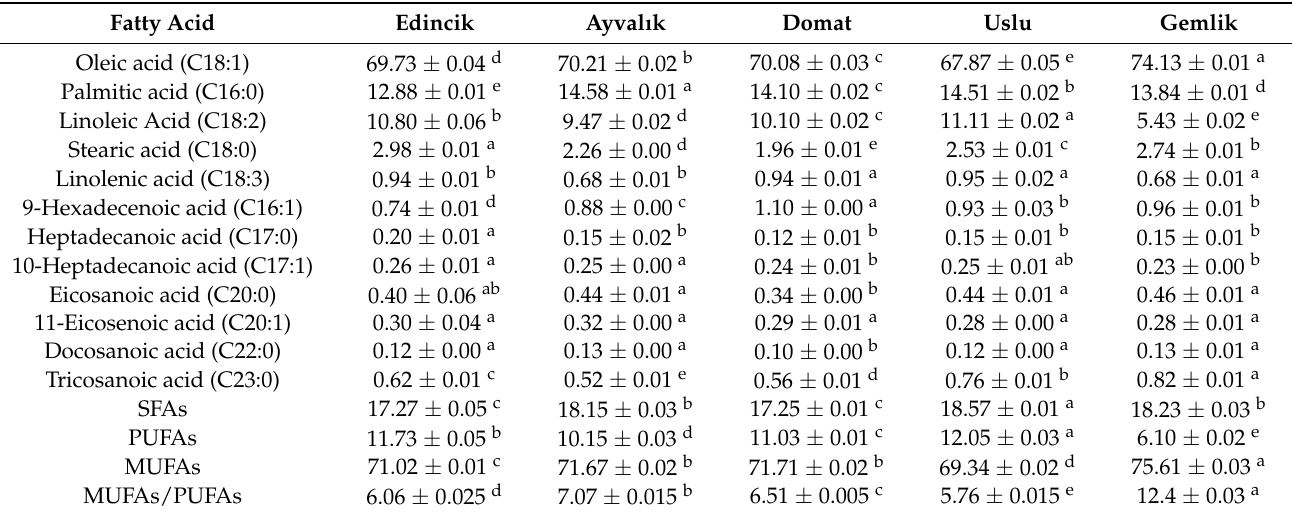
Table 2. Fatty acid profile (%) of EVOOs from five Turkish olive